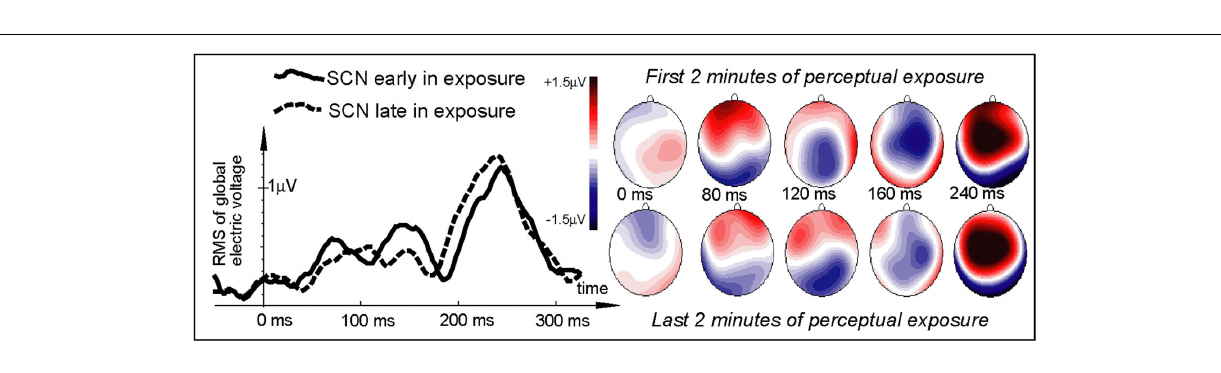
FIGURE 6 | Electric brain response (global activation computed as RMS across all EEG electrodes; grand-average data) for the non-speech signal-correlated noise control stimuli early and late in the learning